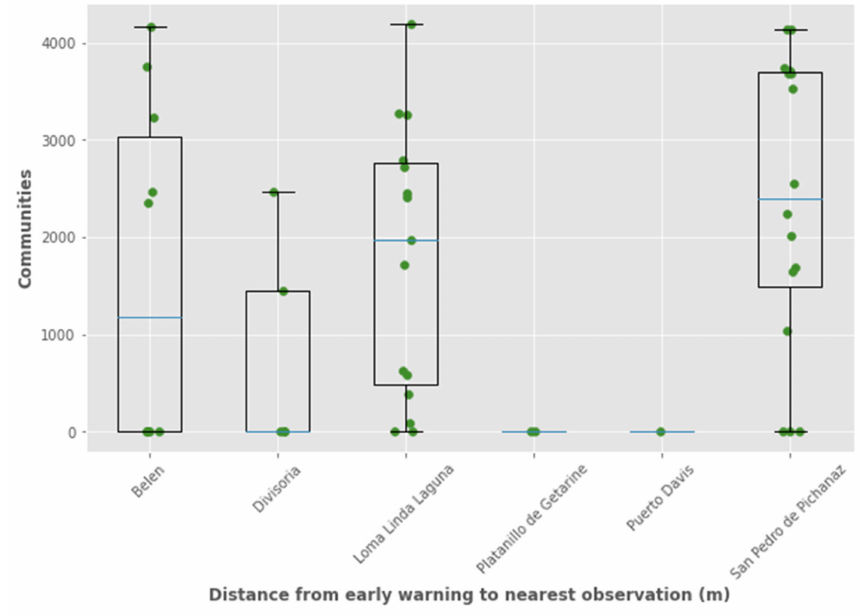
Figure 9. Spatial proximity (meters) of satellite-based alerts to nearest field